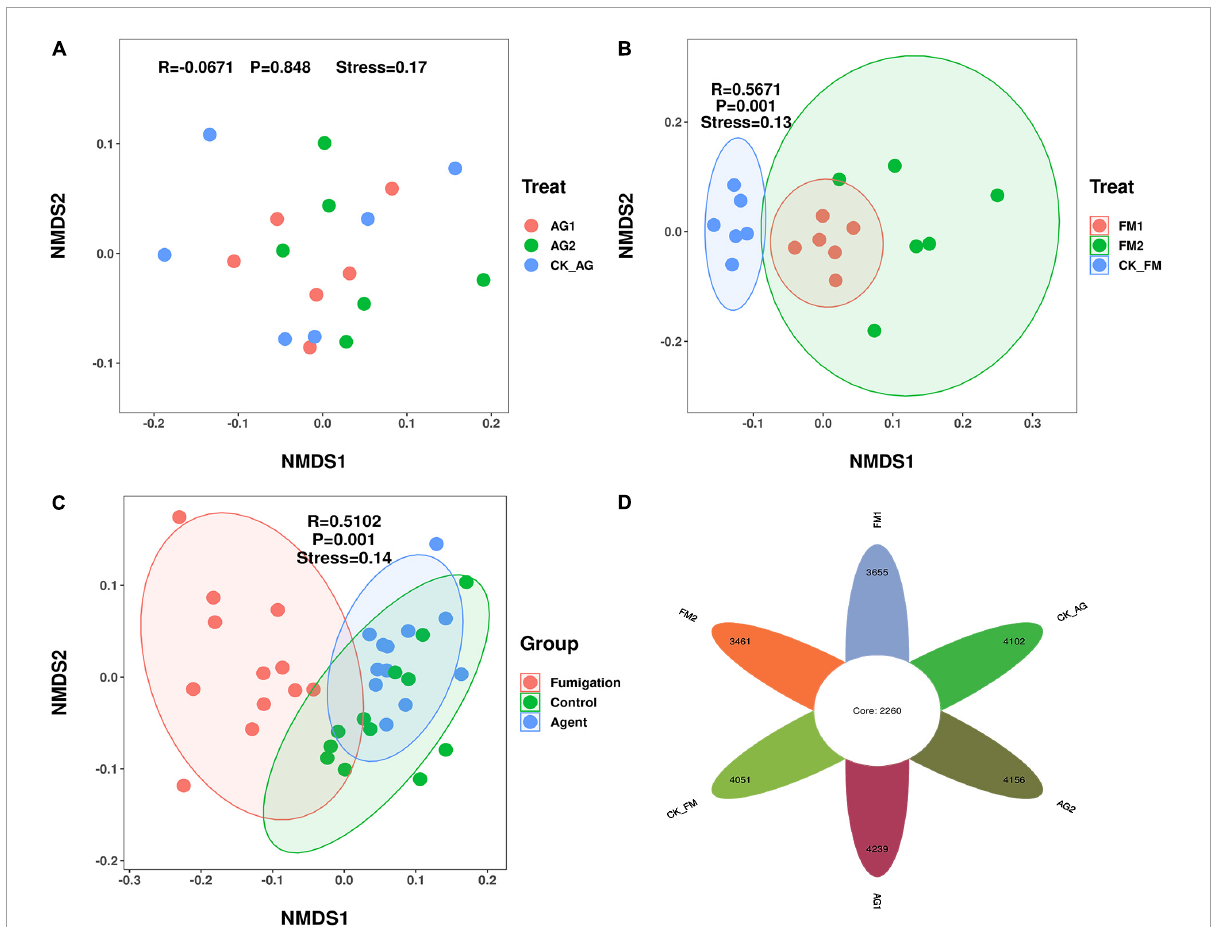
FIGURE3 Bacterial community composition in rhizosphere soil after treated with biological agents (A) or fumigation chemicals (B) . (C) An overall look; (D) Venn diagram. AG1, microbial agent 1 treatment; AG2, microbial agent 2 treatment; CK_AG, untreated control in biological treatment experiment. FM1, CoCl2, cobalt dichloride fumigation treatment; FM2, dazomet fumigation treatment; CK_FM, untreated control in fumigation